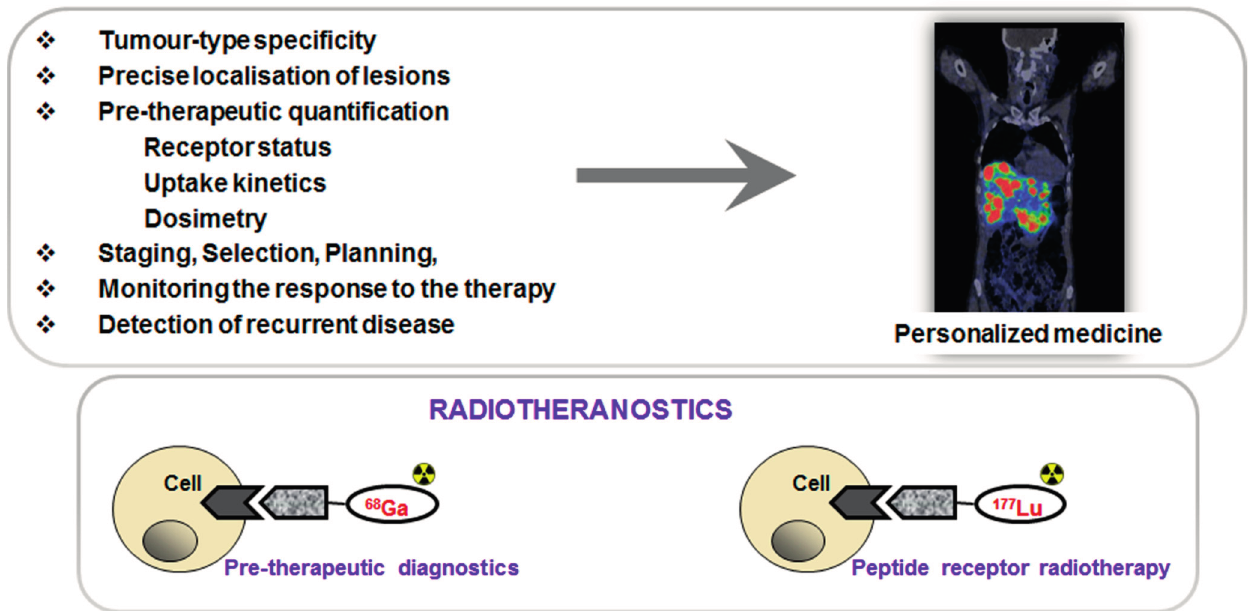
Figure 1. ( Upper panel ) Peptide receptor targeted imaging and radiotherapy provide personalized and thus more effective and efficient treatment of patients. ( Lower panel ) Drawing of the interaction of an agent, either imaging if labeled with 68 Ga ( left ) or radiotherapeutic if labeled with 177 Lu ( right ), with the cell